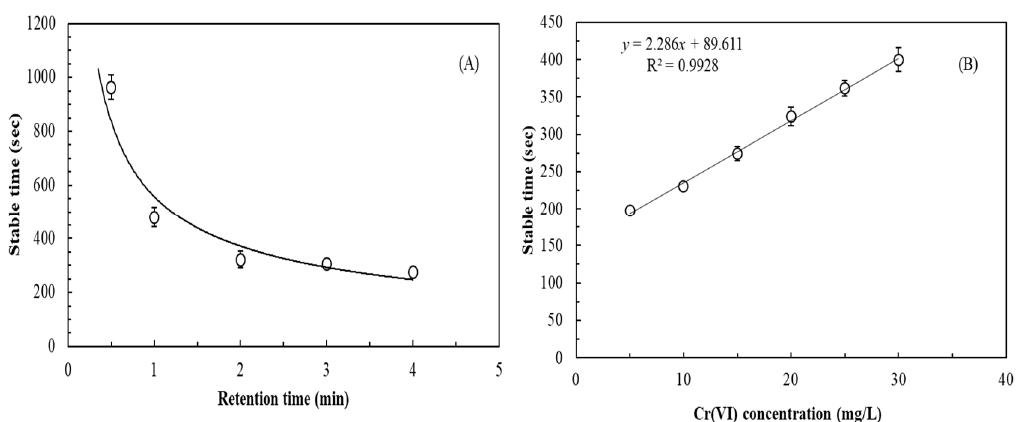
Figure 4. Effects of ( A ) retention time (anolyte: 1/1000 TSB supplemented with 20 mg/L Cr(VI), external resistance: 500 Ω ); ( B ) Cr(VI) concentration (anolyte: 1/1000 TSB supplemented with different Cr(VI) concentrations, liquid retention time: 2 min, external resistance: 500 Ω ) on the stable time of the SCMFC biosensor inoculated with E. aestuarii YC211 in the continuous-flow operation.